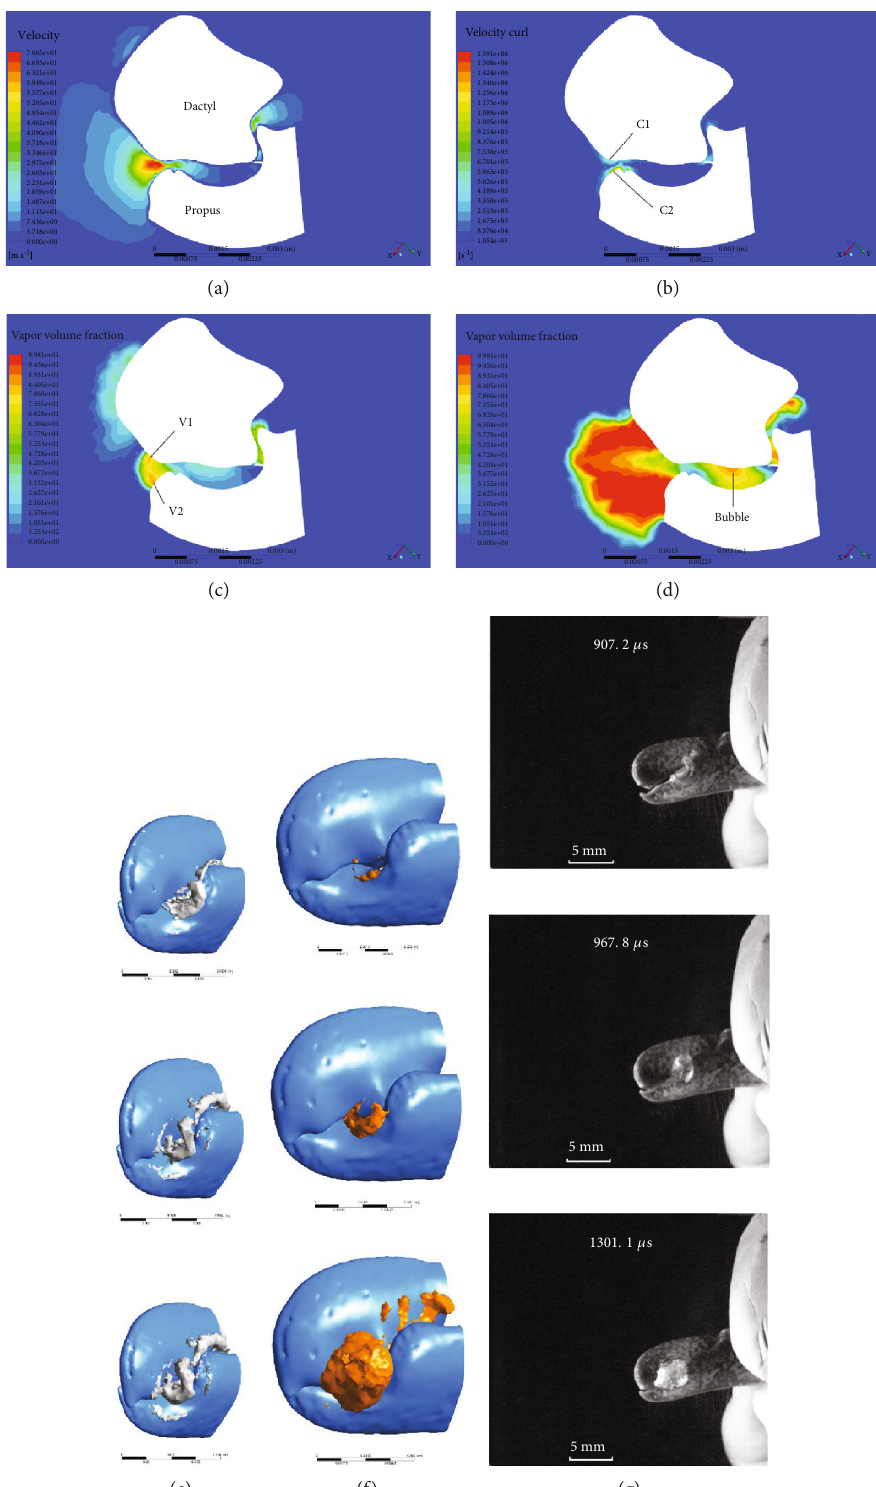
Figure 4: (a) The contour of jet velocity. The core velocity is much higher than the surroundings, forming a submerged jet in water. (b) The contour of vortex. Vortices are formed around the ori fi ce of the nozzle, causing the pressure drop. (c) The contour of vapor. At the position of the vortex, cavitation incepts and the initial shape is toroidal. (d) The cavitation bubble in the socket cavity due to inertia. (e) Vortex core regions are indicated in grey. It gradually develops into a ring structure close to the dactyl. (f) The development of the cavitation bubble. The bubble is formed fi rst at the nozzle ori fi ce, and then changes from a toroidal bubble to a more conical one. (g) The pictures of cavitation bubbles generated by snapper